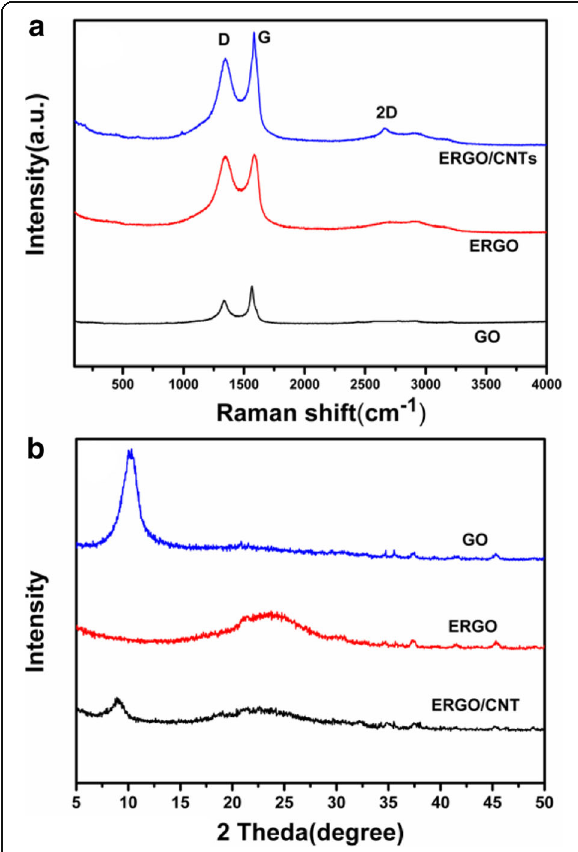
Fig. 3 a Raman spectra and b X-ray diffraction spectra of the pristine GO, ERGO, and ERGO/CNTs